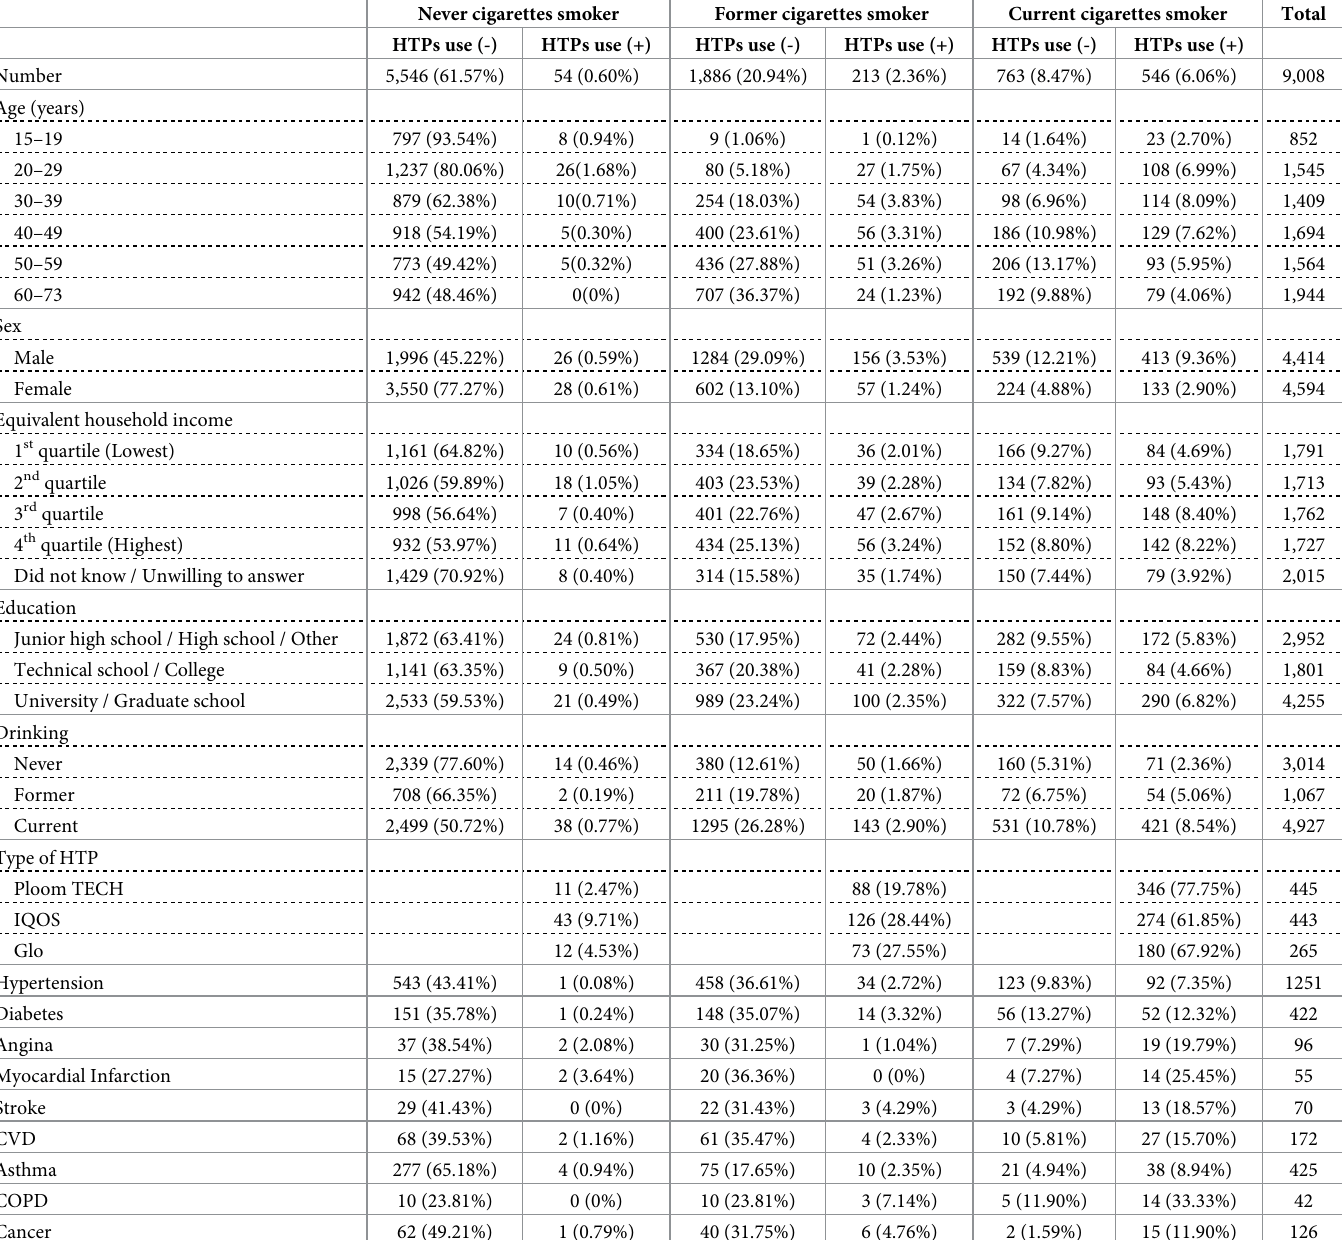
Table 1. Characteristics of